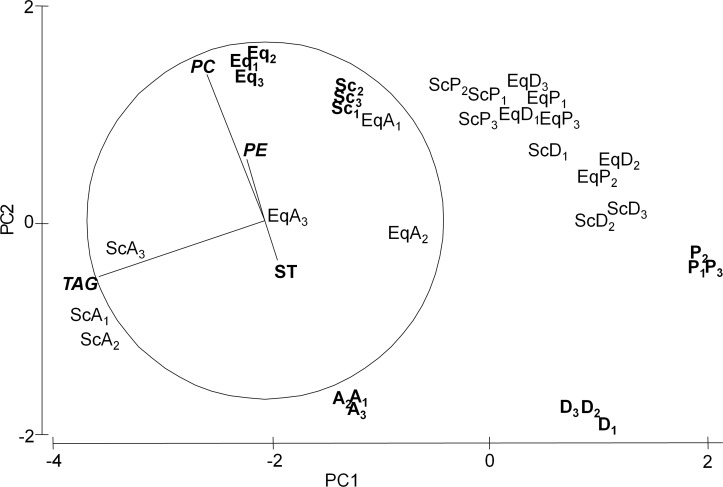
Principal Component Analysis (PCA) plot based on the Lipid Classes (LCs) composition.LCs were analysed for the three types of feed used in the experiment as diets (A: Artemia, P: Phytoplankton, D: Detritus), the caprellids (Eq: C. equilibra, Sc: C. scaura) collected from marinas (used as reference values) and the caprellids fed either Artemia, phytoplankton or detritus for 12 days under laboratory conditions (EqA, EqP, EqD, ScA, ScP, ScD). Subscript numbers (1,2,3) correspond to each replicate value.